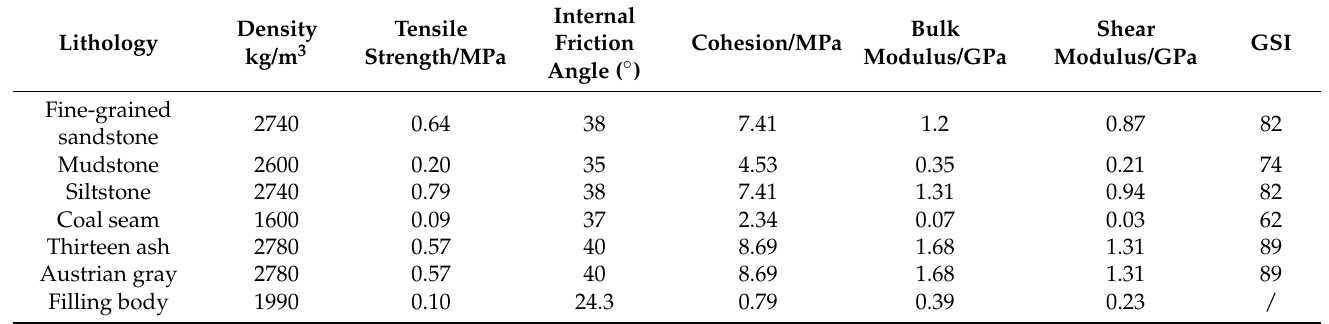
Table 2. Mechanical parameters of rock mass of the model.